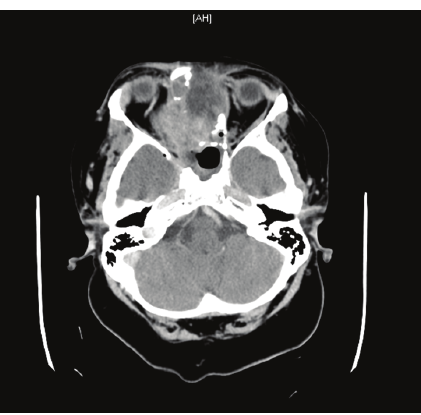
Figure 1: Noncontrasted CT demonstrating tumor extension.